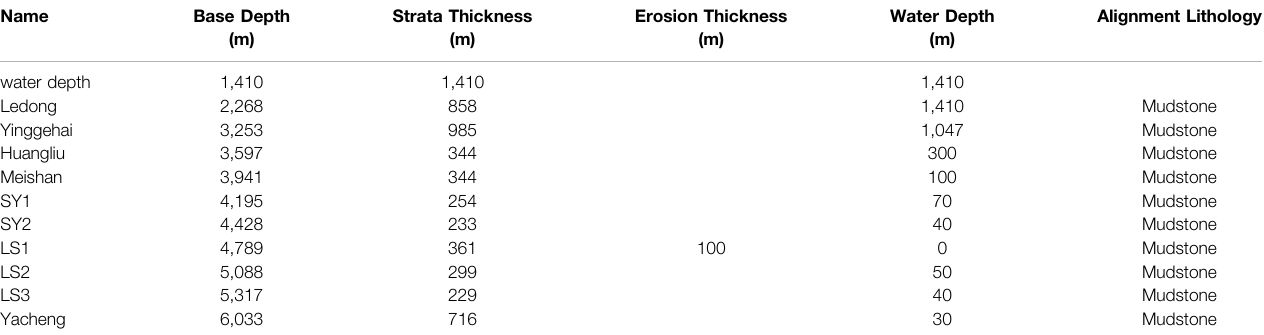
TABLE 1 | Parameters for 1D modeling.